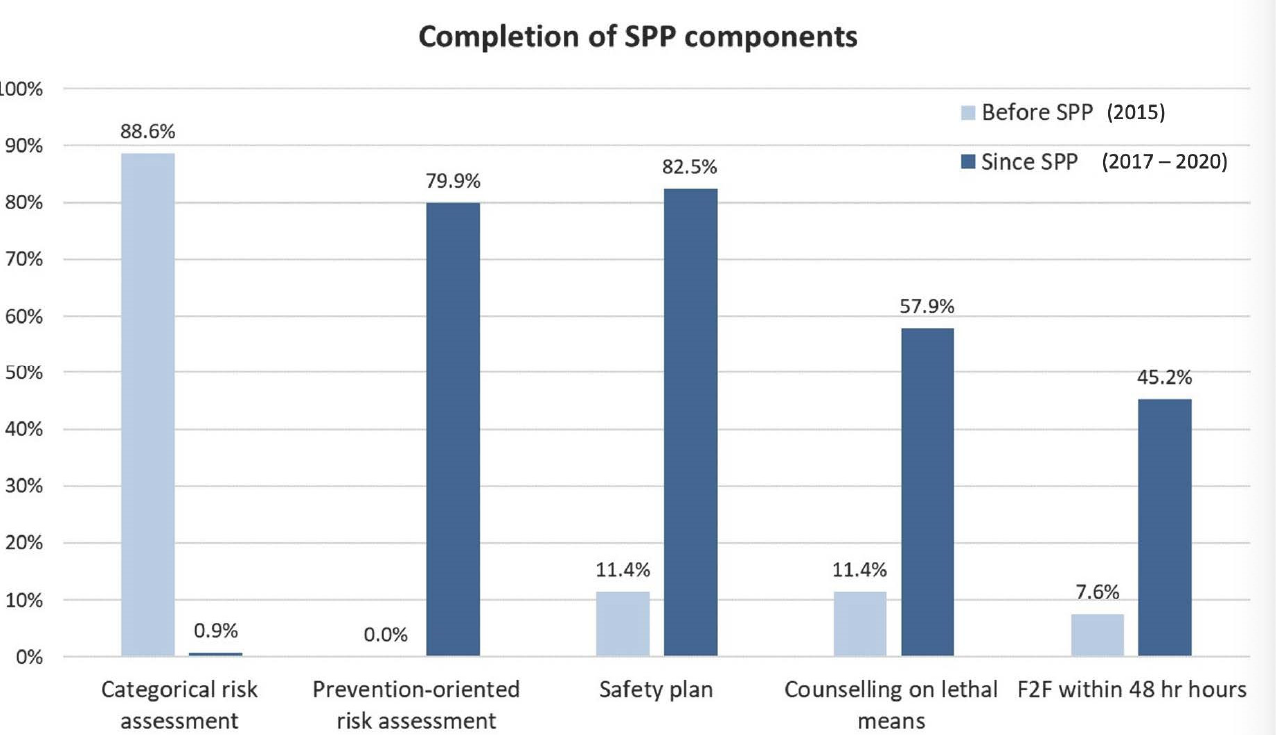
Figure 2. Completion of SPP components.